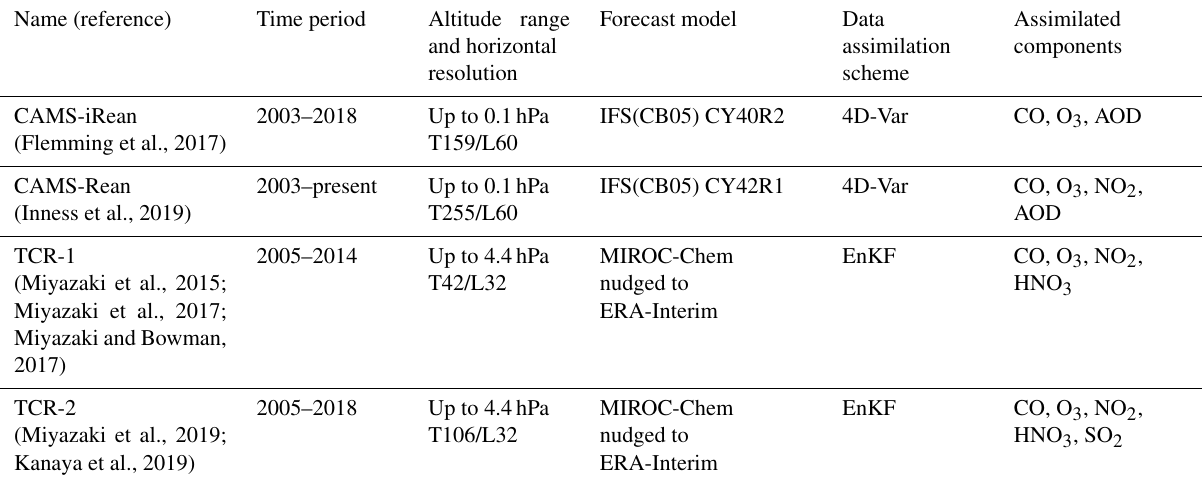
Table 1. Overview of recent reanalysis